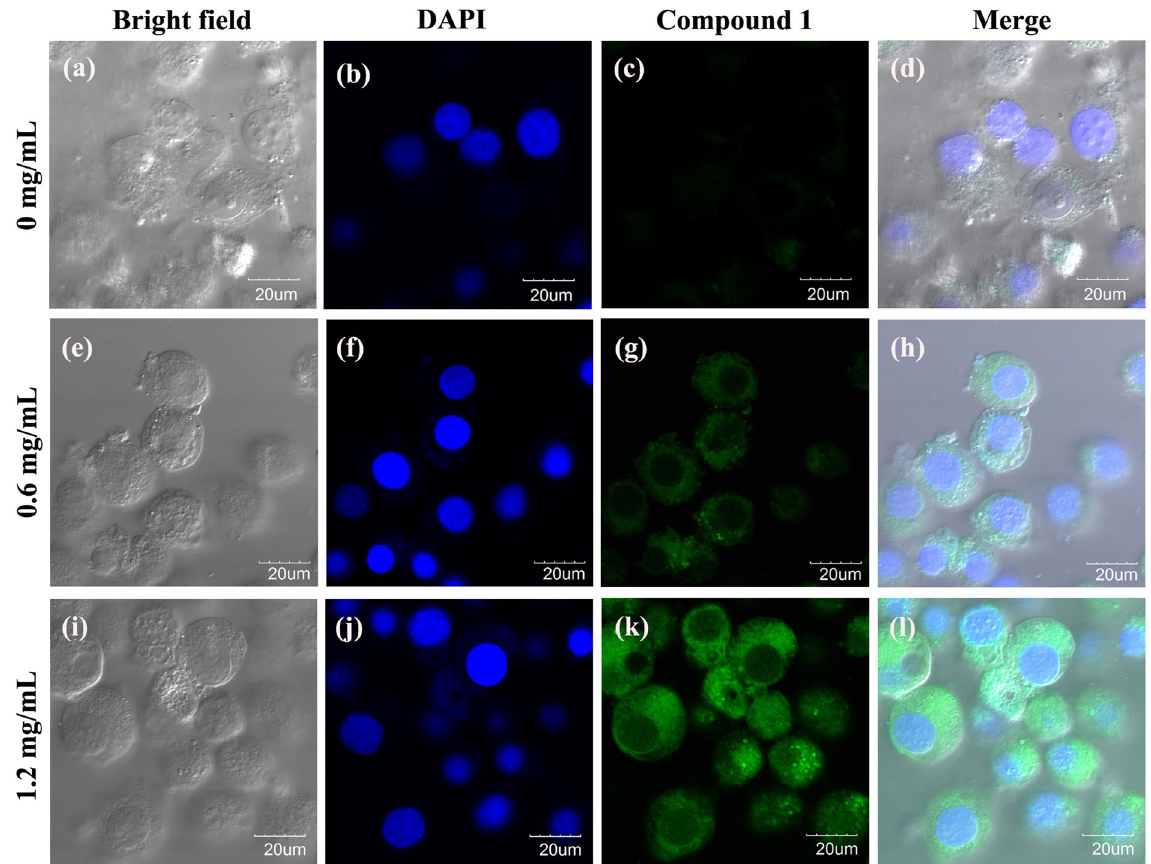
Figure 6. Confocal luminescence images of live Hi5 cells, incubated in PBS for 2 h, at different oxygen levels. ( a – d ) Probe (1) only (20 μ M); ( e – h ) Probe (1) (20 μ M), and antioxidant (0.6 mg/mL); ( i – l ) Probe (1) (20 μ M), and antioxidant (1.2 mg/mL). ( a , e ) and ( i ) Are bright-field images. ( b , f ) and ( j ) Are blue channels collected at 425–475 nm, stained with DAPI. ( c , g ) and ( k ) are green channels collected at 495–550 nm, stained with probe 1. ( d,h and l ) Are